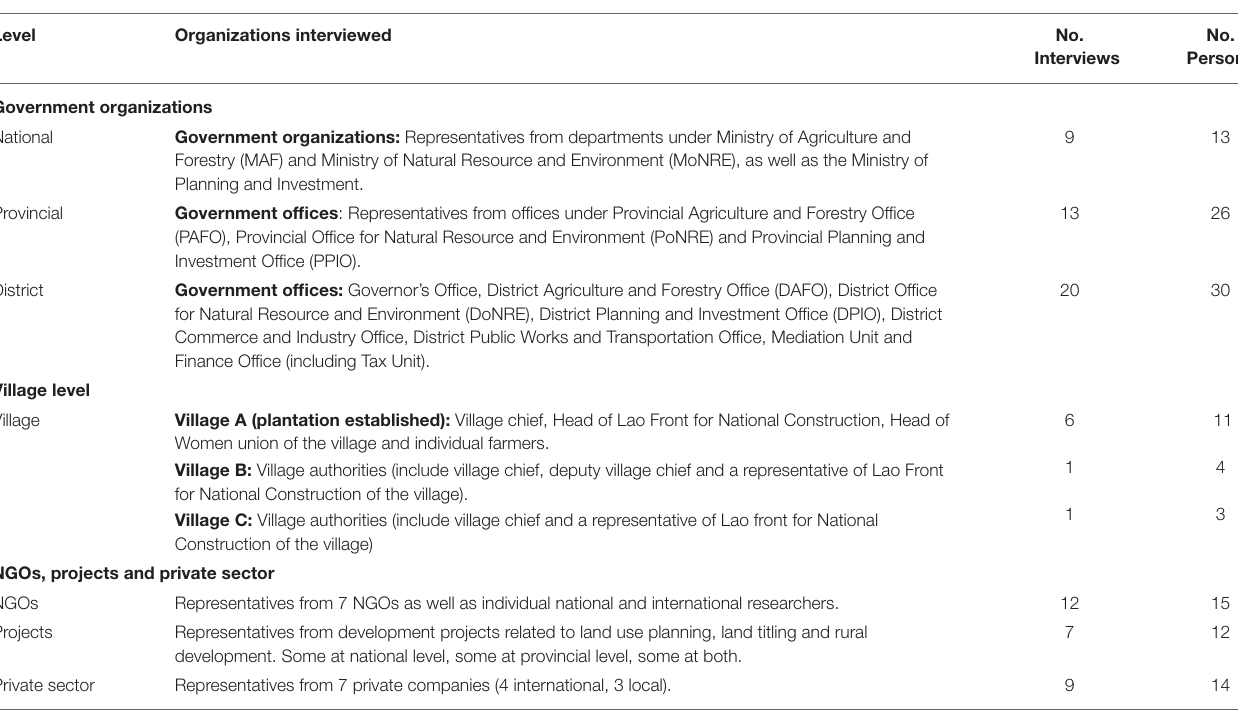
TABLE 1 | Interviews conducted between 2013 and